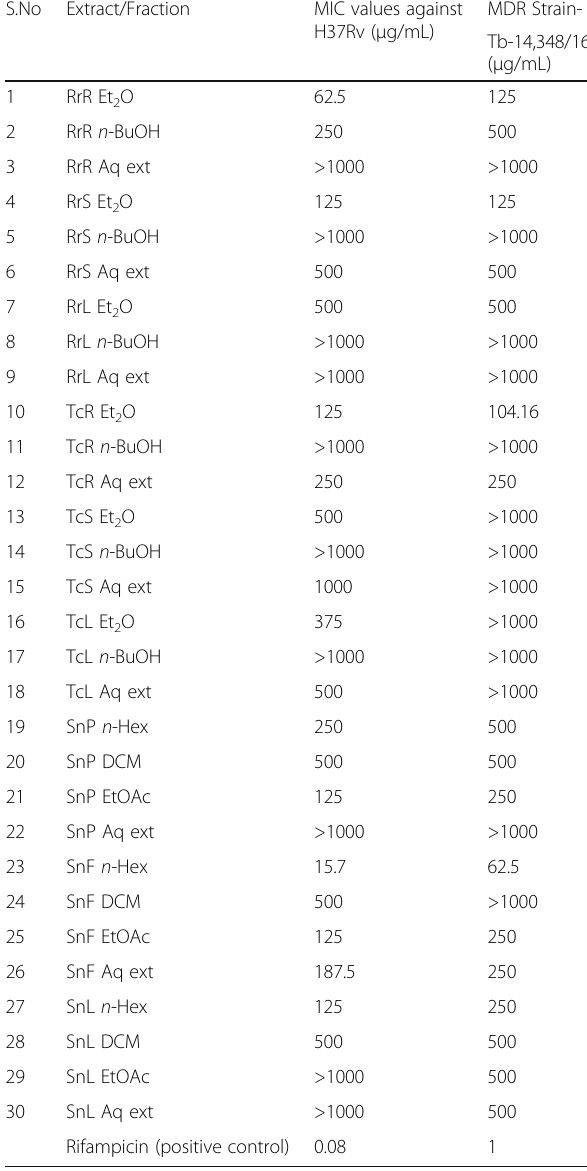
Table 4 Minimum inhibitory concentration (MIC in μ g/mL) of the antimycobacterial activity of crude extracts/fractions of three orchids against H37Rv and MDR